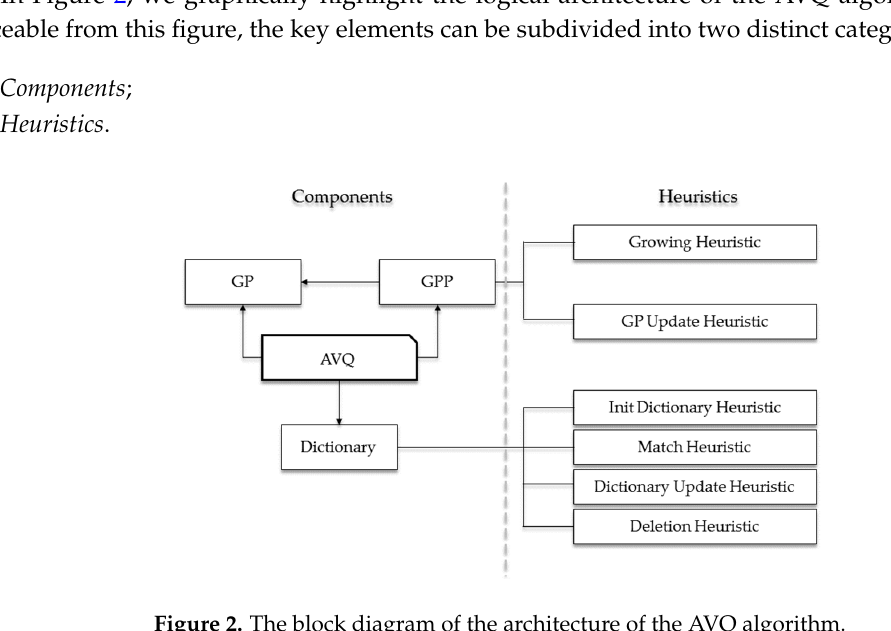
Figure 2. The block diagram of the architecture of the AVQ algorithm.